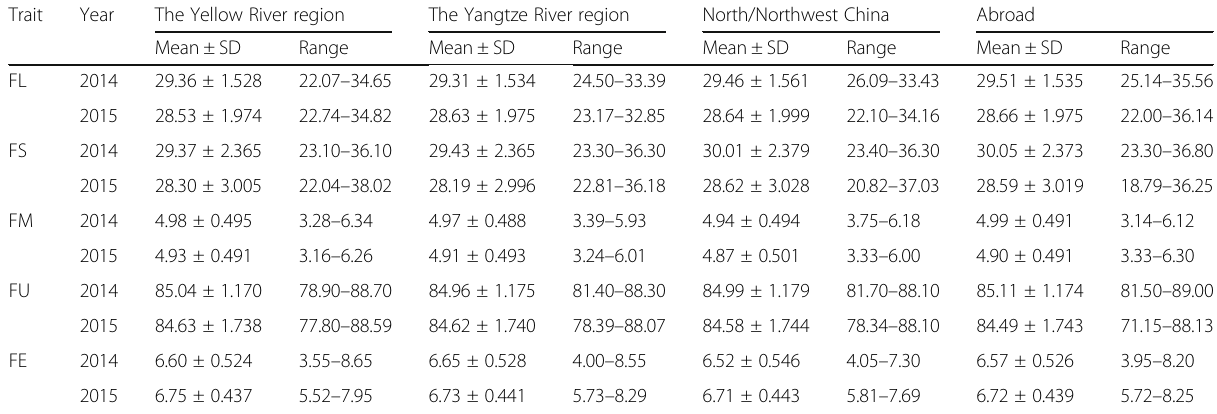
Table 1 Descriptive statistics of the five measured traits in 719 upland cotton accessions from different regions Trait Year The Yellow River region